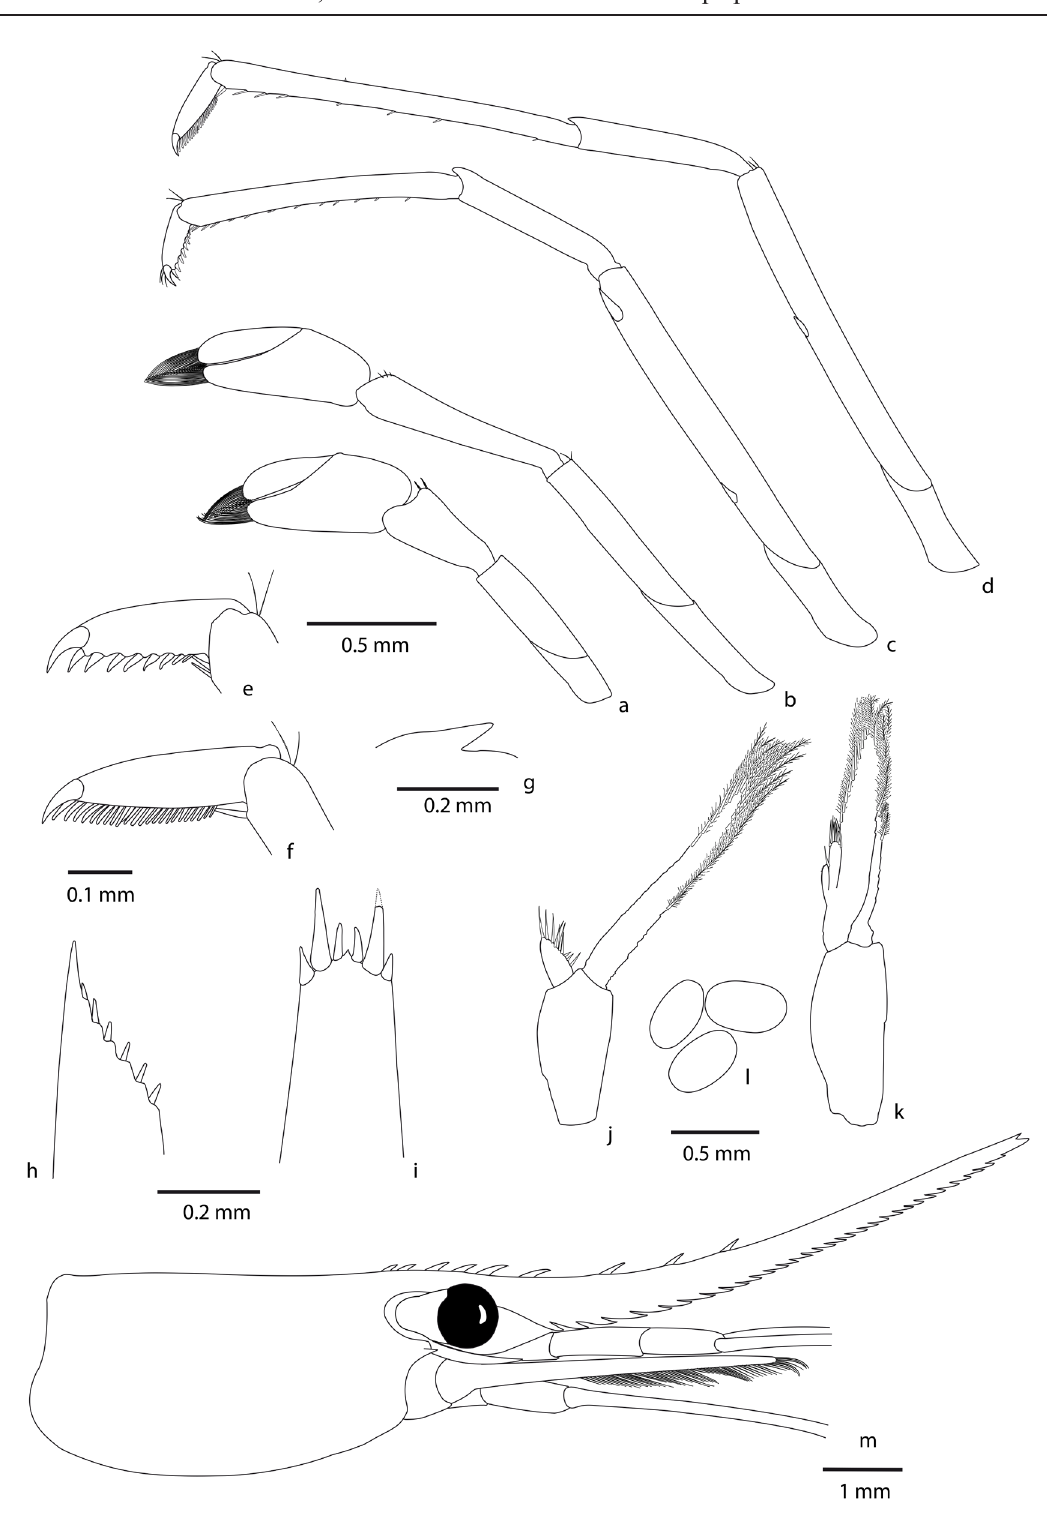
Fig. 4. Caridina gracilirostris (De Man, 1892). a . First pereiopod. b . Second pereiopod. c . Third pereiopod. d . Fifth pereiopod. e . Dactylus of third pereiopod. f . Dactylus of fifth pereiopod. g . Pre- anal carina. h . Uropodal diaeresis. i . Telson. j . First male pleopod. k . Second male pleopod. l . Eggs. m . Cephalothorax. MNHN-IU-2018-2804 (a–b, d, f–k), MNHN-IU-2018-2805 (c,e,m) and MNHN- IU-2018-2807